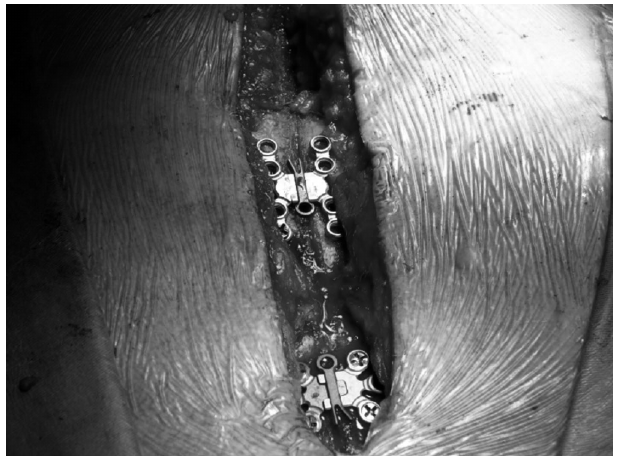
Fig. 3 – Fixing the sternum - Image of the plates little star and “H” narrow